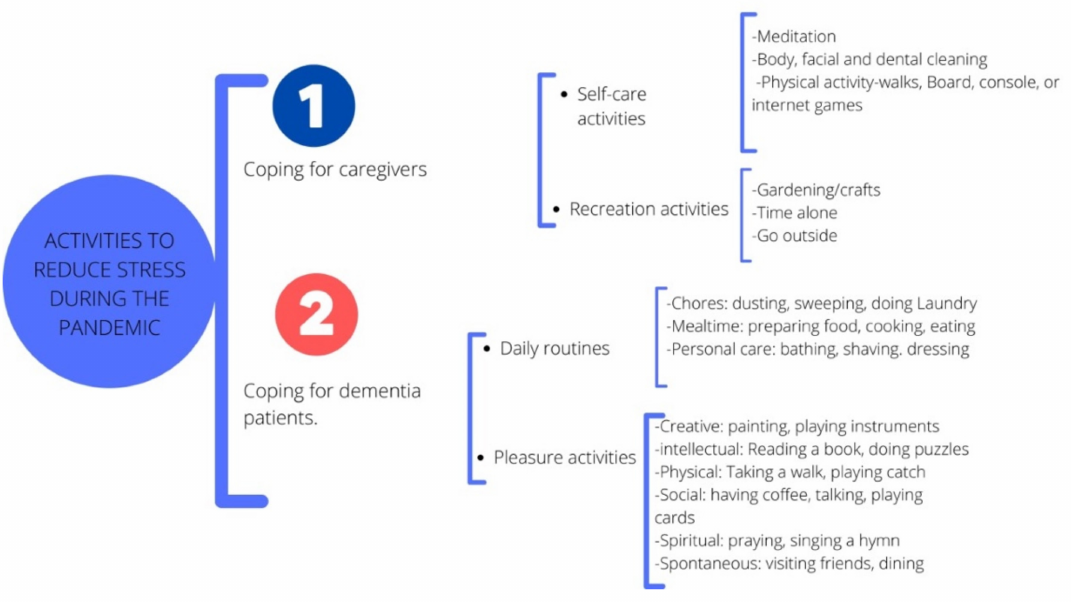
Figure 2. Activities to reduce stress during the pandemic. The design of the image is own creation, but the information of the image was based on recommendations to develop activities in the house of the Alzheimer’s Association and in the article of Bacsu